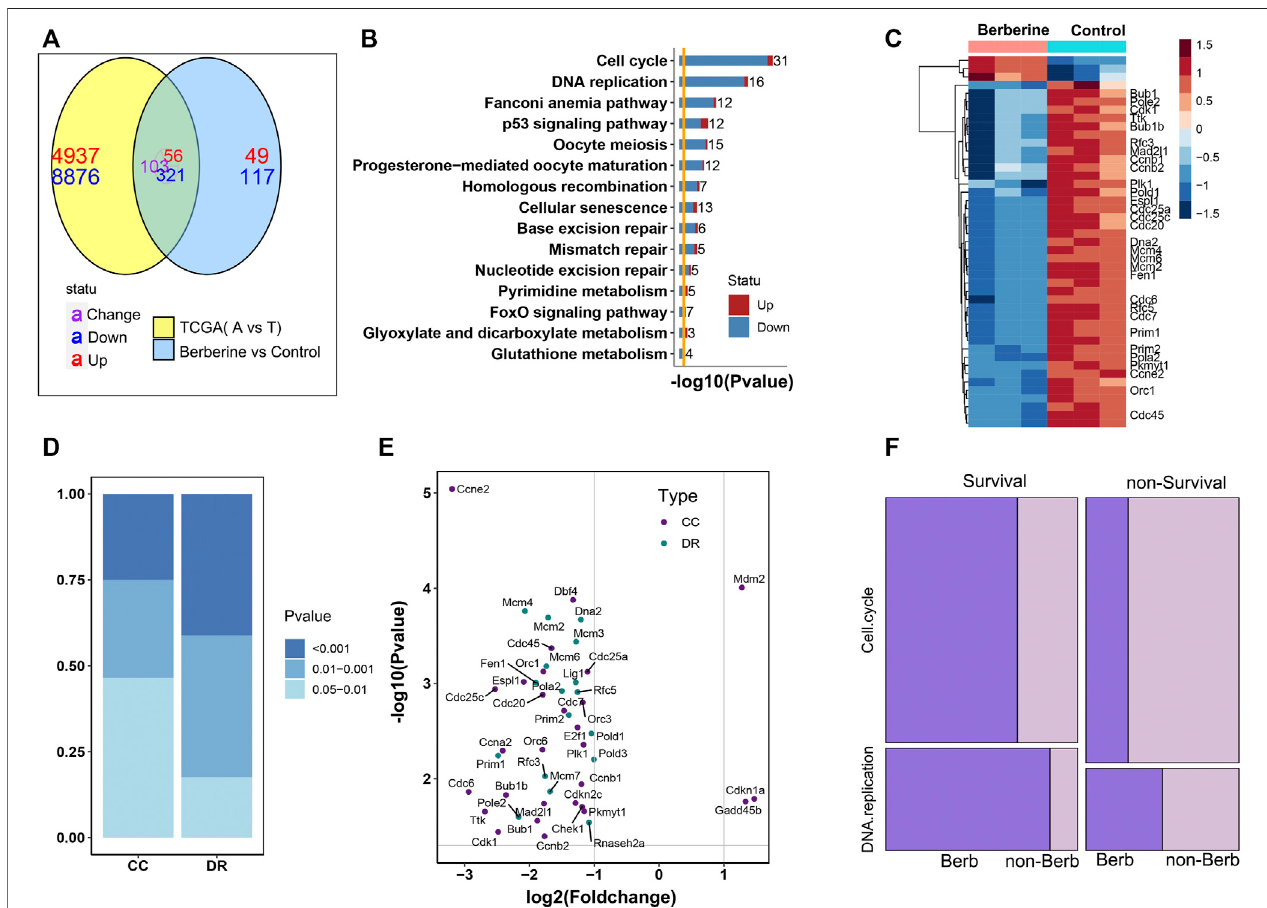
FIGURE 2 | Berberine down regulates survival related genes in DNA replication pathway. (A) The Venn map of DEGs in berberine cohort and TCGA-LUAD cohort showedthatberberinecouldchangetheup-regulatedgenesintodown-regulated genes,andtheenrichmentof(321+56)geneswiththesame upanddown-regulated directionafter berberinetreatment. (B) KEGG enrichmentanalysisshowedthatthe common differential genesinberberinetreatmentand TCGA were mainlyenriched in Cell cycle and DNA replication pathway, and tended to be down regulated. (C) Heatmap of Cell cycle and DNA replication related DEGs after the treatment of berberin (only the survival related DEGs were labled on the right). (D) Barplot of Cell cycle and DNA replication DEGs ’ distribution on three intervals cutted by p -value. DNA replication genes tend to have lower p -value. (E) Scatter plot of Cell cycle and DNA replication DEGs, with the x-axis as log2 (Fold change) and y-axis as – log10 ( p -value) in the berberine cohort. (F) Mosaic plot of survival and non-survival related DEGs of TCGA-cohort. Survival related DEGs of berberine cohort were colored in dark violet, while non-survival related DEGs of berberine cohort were colored in light violet. The results showed that berberine signi fi cantly affected the survival genes in Cell cycle and DNA replication, especially in DNA replication